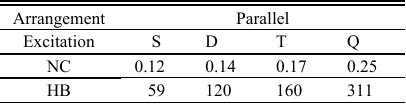
FIGURE 12. Magnitude of induced voltage across the silicon diode expressed by (25) in infinite collinear array of nonlinear antennas under double-tone and normal incidence by NC and HB techniques.